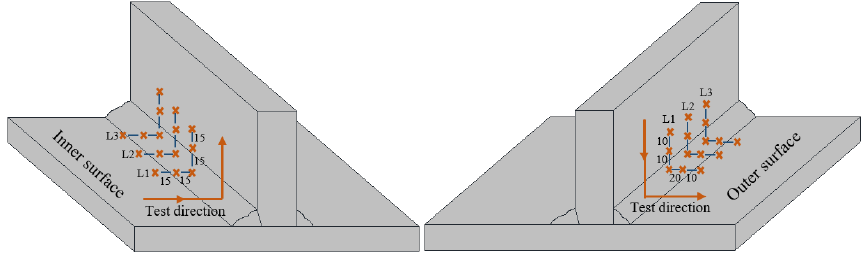
The surface residual stresses after welding were measured by the indentation strain gauge method along paths L1, L2, and L3, as shown in Figure 2. Five points were meas- ured on every path.